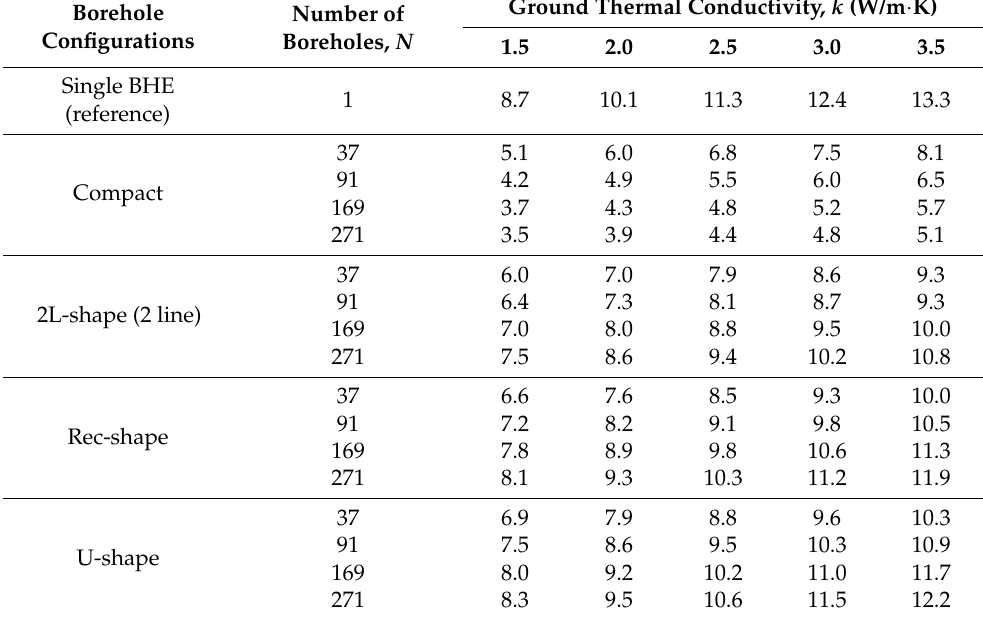
Table A2. Results for heat transfer rate per borehole ( Q bhe ) for heating-dominant load